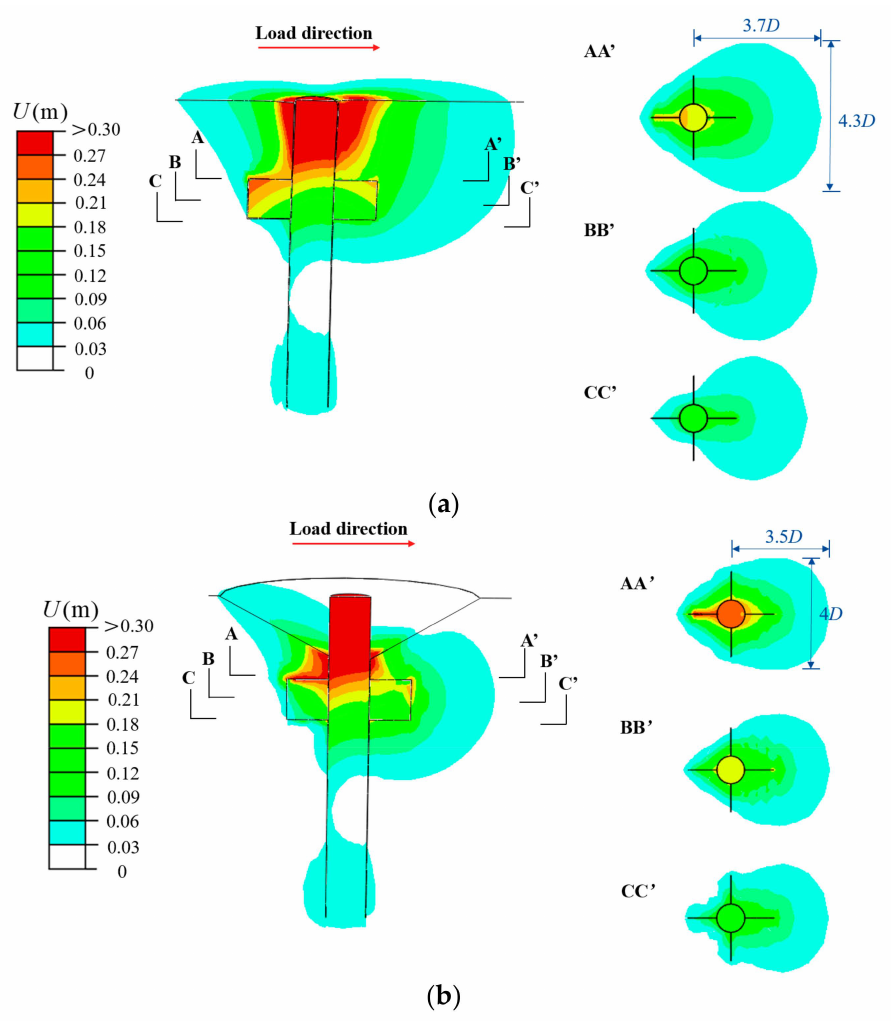
Figure 9. Soil displacement in the plane of symmetry and the planform at θ = 2 ◦ : ( a ) the winged monopile without local scour; ( b ) the winged monopile with local scour ( S/D =